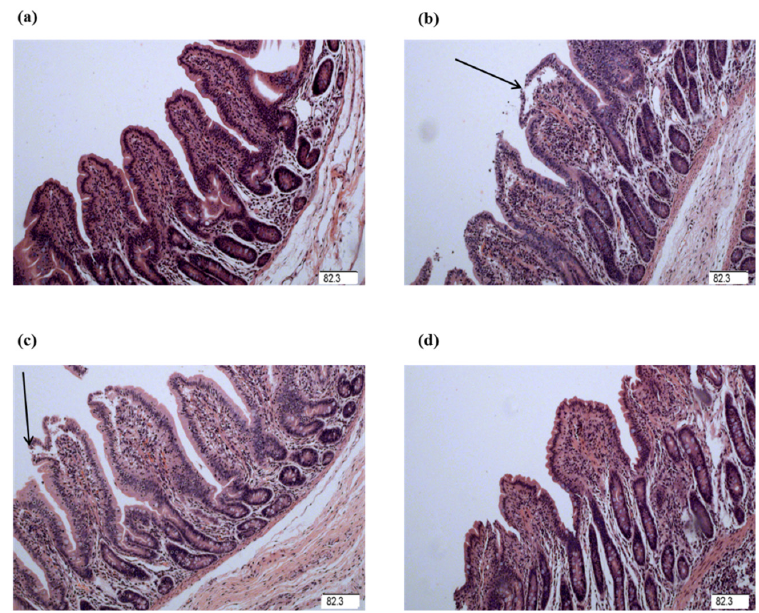
Figure 2. Ileal mucosal histological appearance (hematoxylin and eosin). ( a ) Pigs fed a control diet and injected with sterile saline. No obvious damage was observed. ( b ) Pigs fed a control diet and injected with LPS. Intestinal mucosa was seriously damaged by LPS. Arrow represents the damaged intestinal mucosa in the piglets. ( c ) Pigs fed a 1.0% Gly diet and injected with LPS. Intestinal damage was still existed. ( d ) Pigs fed a 2.0% Gly diet and injected with LPS. Intestinal damage was alleviated. Arrow represents the damaged intestinal mucosa in the piglets. Original magnification 100×. Scale bars = 82.3 μ m.